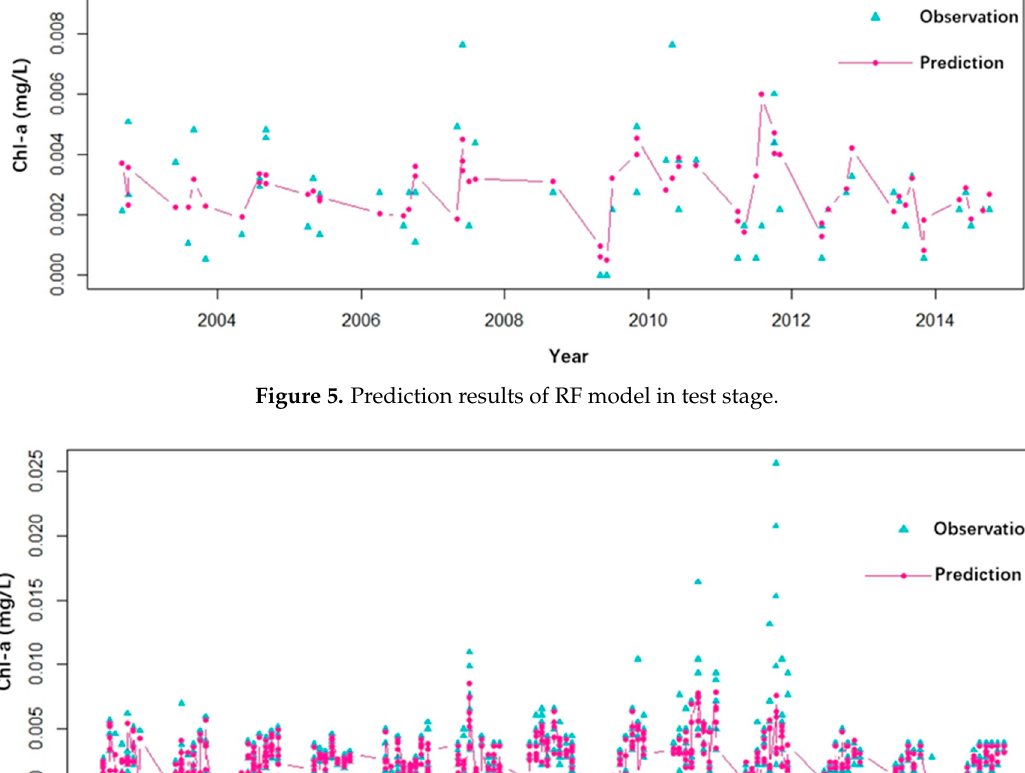
Figure 4. Prediction results of RF model in train stage.